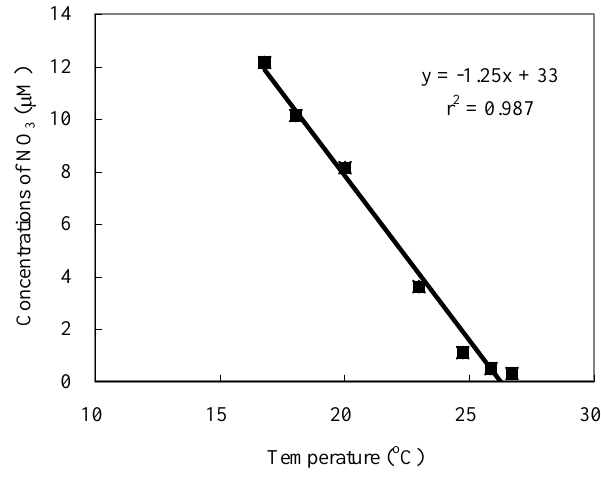
Fig. 6. Relationship between and sea surface temperature (SST) and nitrate concentration in the study area of the southern East China